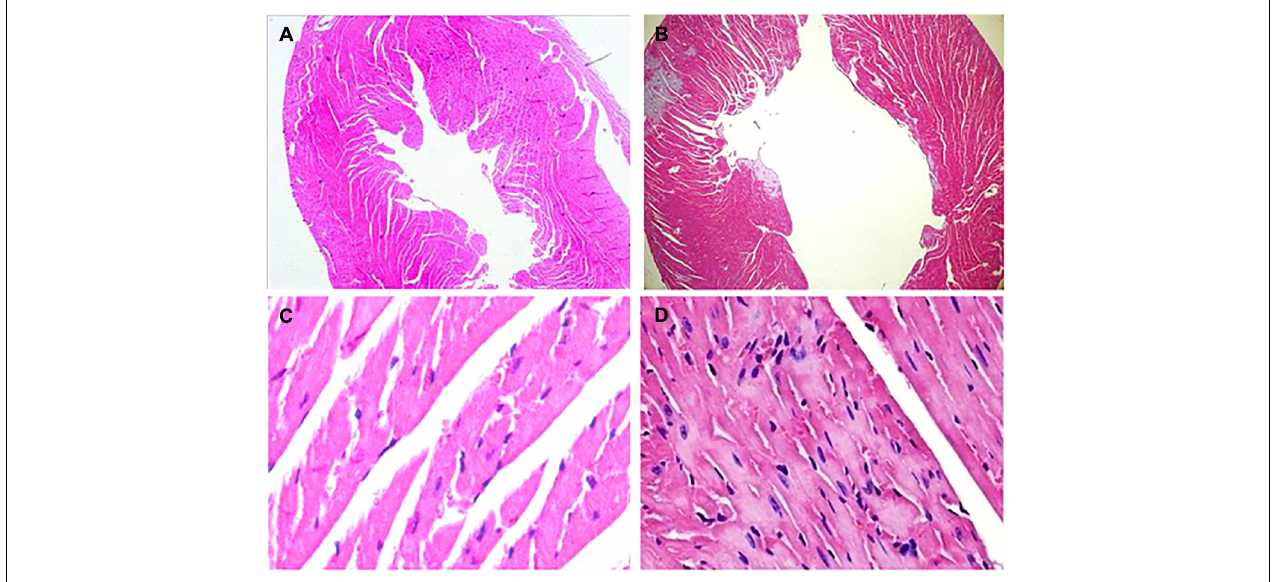
FIGURE 4 | HE staining on the 42nd day. HE staining revealed that the heart was dilated and a large number of interstitial fibroblasts had infiltrated into the myocardium in CVMC1 group. A ( × 40) and C ( × 400) are for Normal control 1 group. B ( × 40) and D ( × 400) are for CVMC1